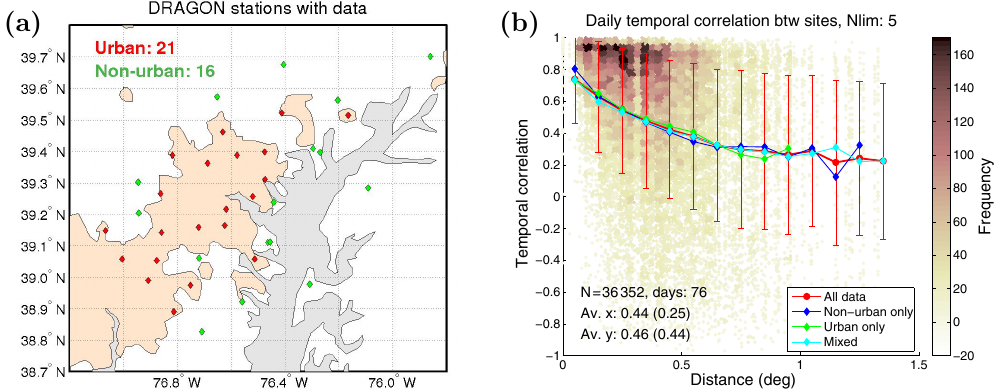
Figure 1. (a) Map of the DRAGON 2011 area, with 21 urban AERONET sites (red symbols) and 16 non-urban (green symbols) sites with data. The gray area is water (Chesapeake bay), and the light brown color shows urban areas. (b) Temporal correlation between different AERONET sites in the DRAGON area as a function of the distance between the sites. The lines show average correlation for distance bins for different area types, and the error bars show the corresponding standard deviation. Differences between urban, non-urban and mixed (both urban and non-urban) are